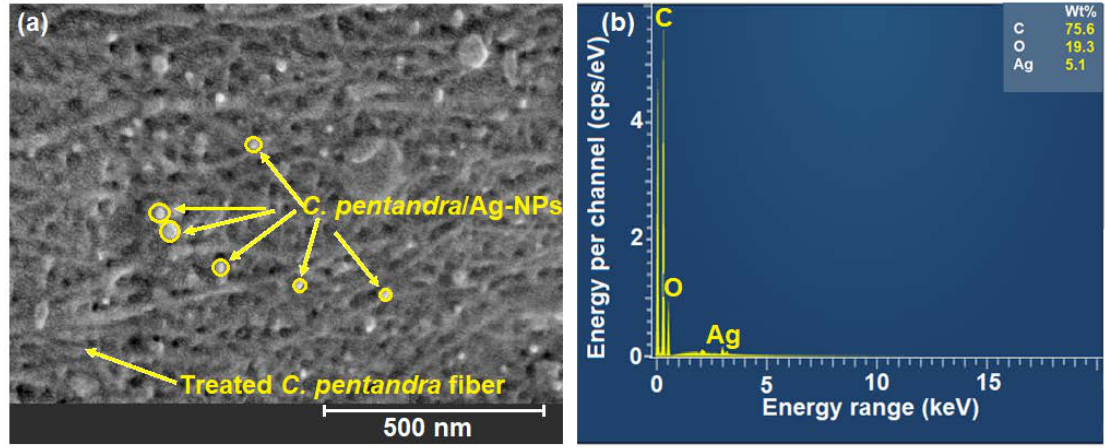
Figure 11. ( a ) SEM image and ( b ) EDX spectra of C. pentandra /Ag-NPs .